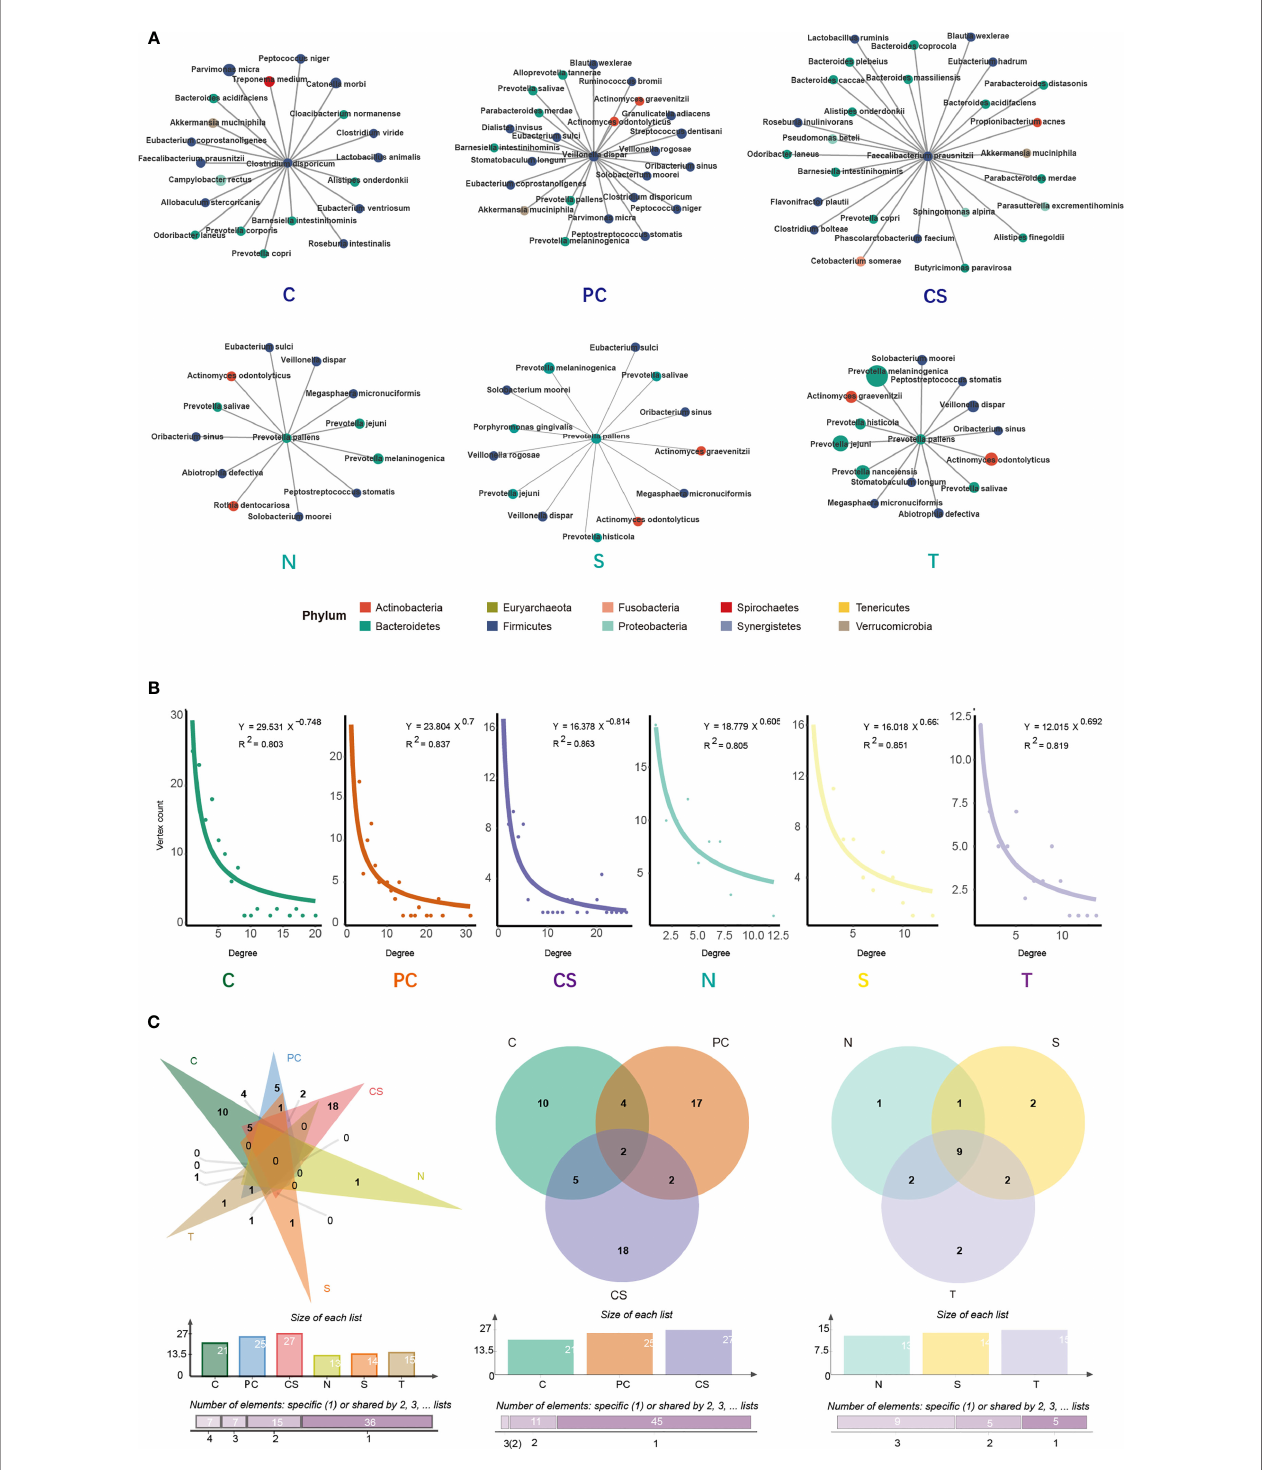
FIGURE 4 | SparCC analysis of the co-occurrence network and core microbiome. (A) Key species network in tumor tissue, paracancerous tissue, cancer surface, anatomically matched contralateral normal mucosa, saliva, and tongue coat. Each node represents a specie, and each edge represents a signi fi cant co-occurrence relationship. (B) SparCC network followed the law of power-law distribution. (C) Venn diagram depicts the overlap of bacterial species among the different niches. C, tumor tissue; PC, paracancerous tissue; CS, cancer surface; N, anatomically matched contralateral normal mucosa; S, saliva; T, tongue